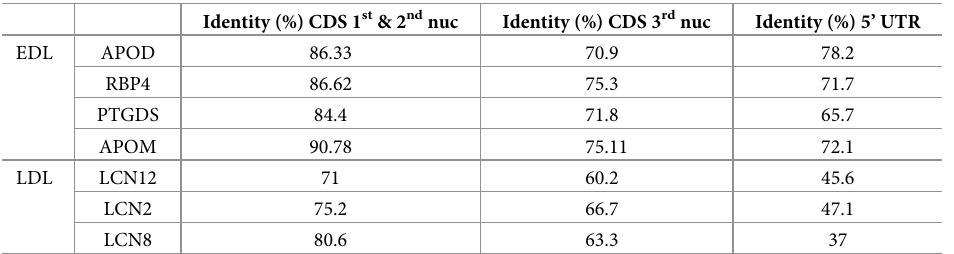
Table 2. 5’ UTR—CDS divergence